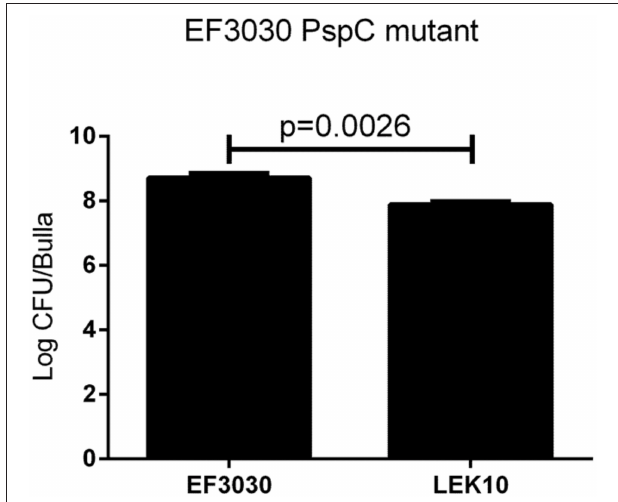
FIGURE 3 | Encapsulated strain EF3030 (serotype 19F) middle ear pathogenesis in chinchillas are not mediated by PspC. There is a significant decrease in the amount of bacteria recovered from the middle ear of chinchillas when comparing wildtype EF3030 to pspC gene deletion (LEK10). Data represents samples from four